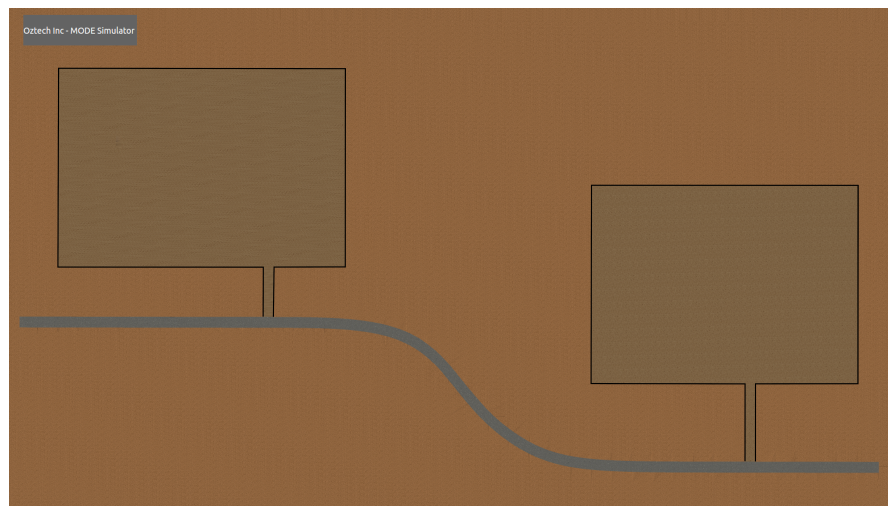
Figure 4. Environment model of the operation description. Top-left area is the loading area while the middle-right area is the unloading area.